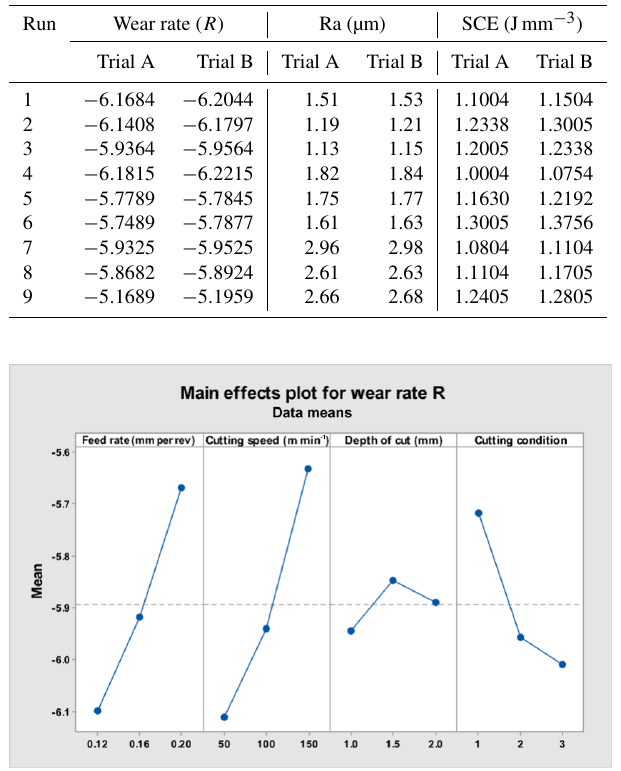
Figure 4. Main effects plot for R .